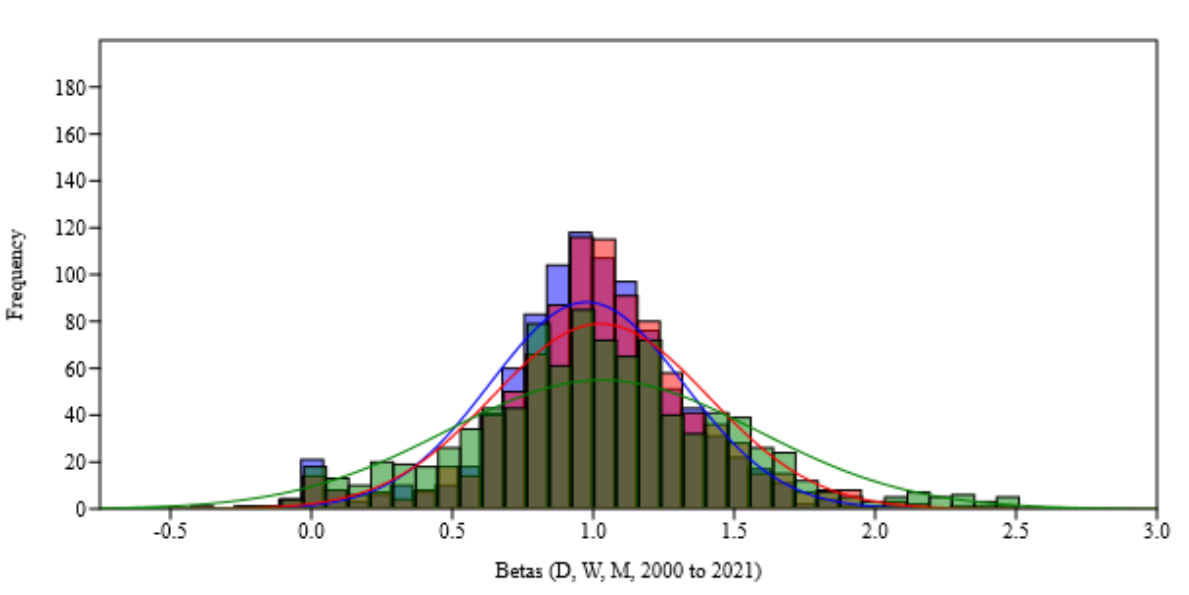
Figure A1. Histograms of betas (daily, weekly and monthly return series, 2000–2021). The monthly betas have the relatively largest variance (flattest histogram, in green hue), while the daily betas have the lowest variance (blue histogram). A total of 99% of betas are in the [ − 1, +3] range. Conducting the Jarque-Bera test (Jarque and Bera 1980) for (cid:3041) (cid:4666)𝐾 − 3(cid:4667) (cid:2870) (cid:4673), indicates that the daily betas have more of a normal (cid:4672)𝑆 (cid:2870) + (cid:2869) normality 𝐽𝐵 = (cid:2874) (cid:2872) approximation than the monthly betas.